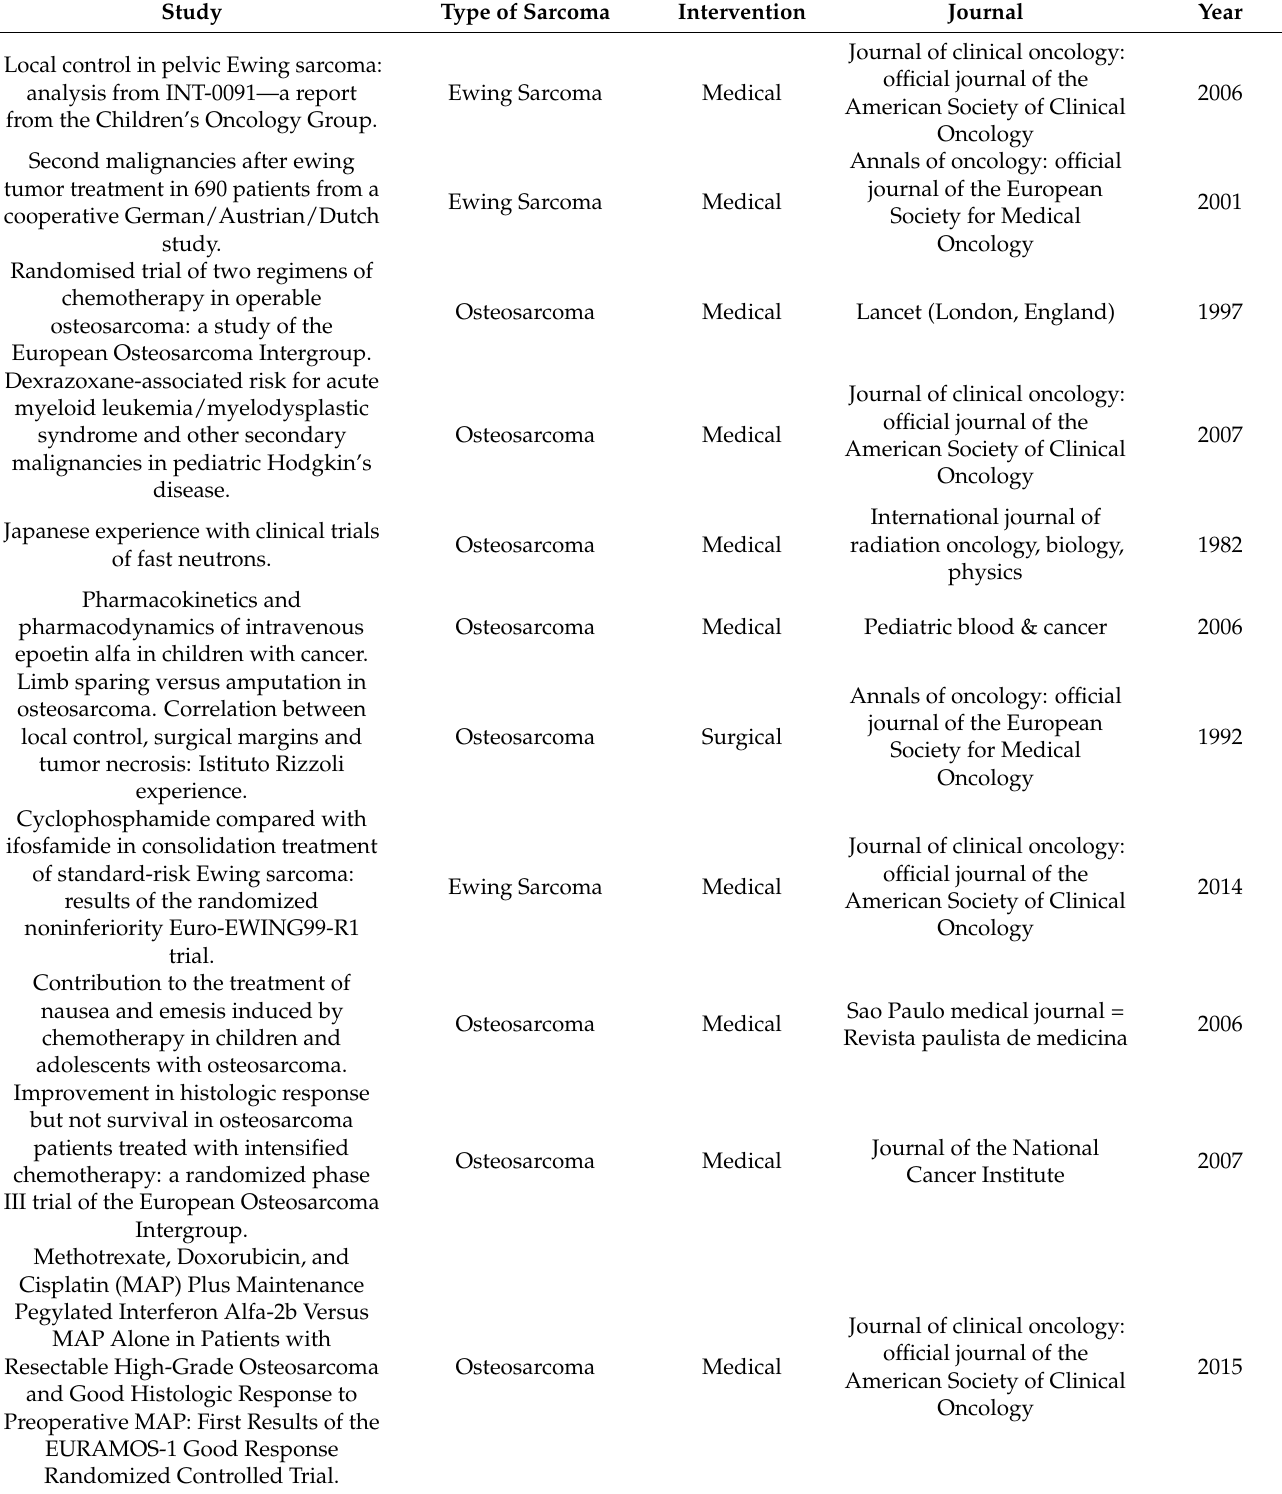
Table A3. Studies with any domain with a high risk of bias